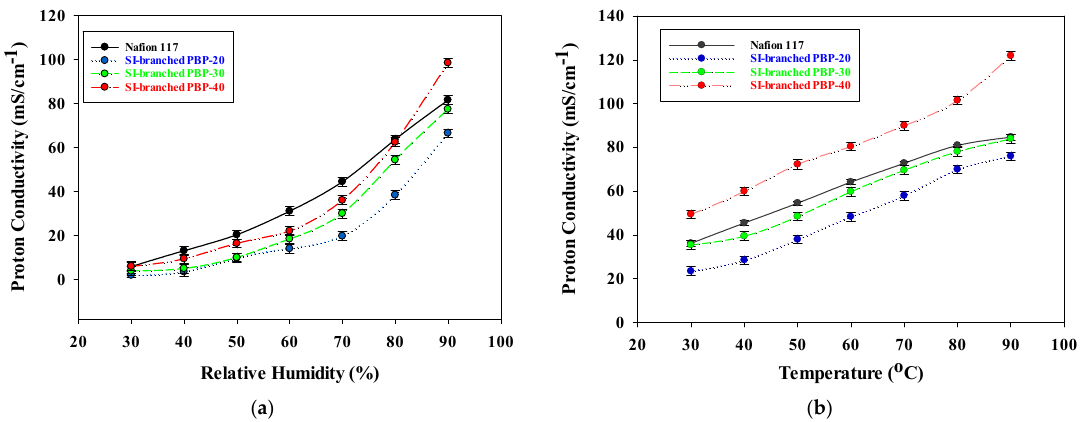
Figure 4. Proton conductivity for the SI-branched PPBP polymer membranes in ( a ) different relative humidity at 90 °C ( b ) different temperatures at 90% RH.